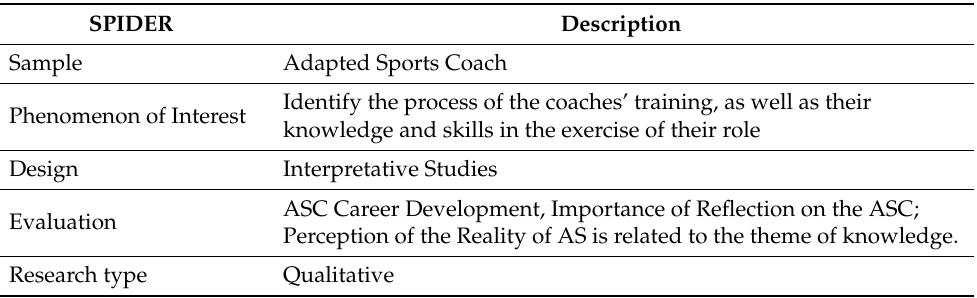
Table 1. Development of a Search Strategy and Selection of Eligibility Criteria Based on the SPI- DER Acronym. SPIDER Description Sample Adapted Sports Coach Phenomenon of Interest